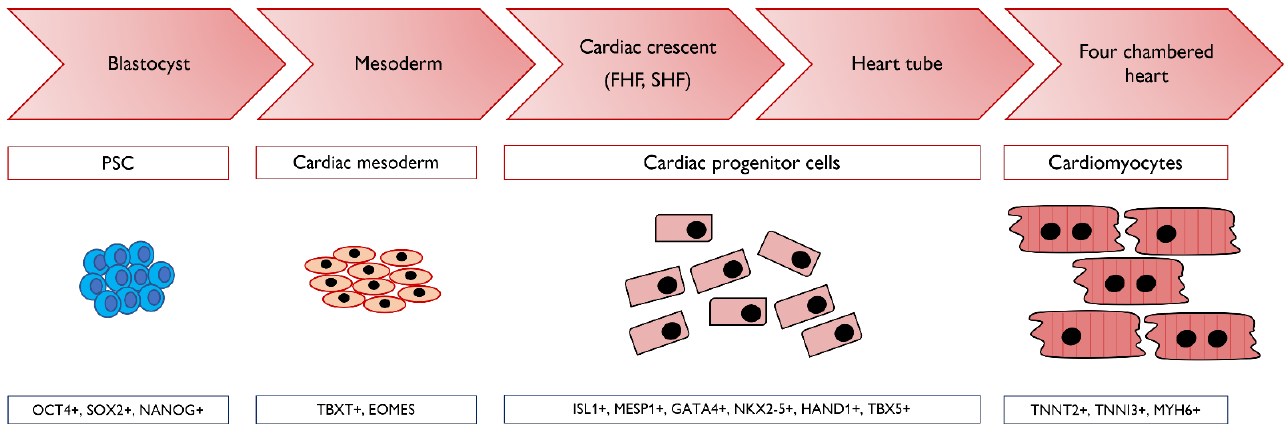
Figure 2. Comparison of cardiac development during prenatal days with PSC differentiation stages. Key genes are also shown at each time-point. FHF: First Heart Field, SHF: Second Heart Field.